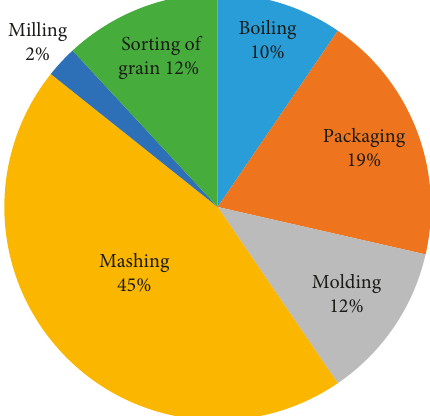
Figure 4: The most critical control points